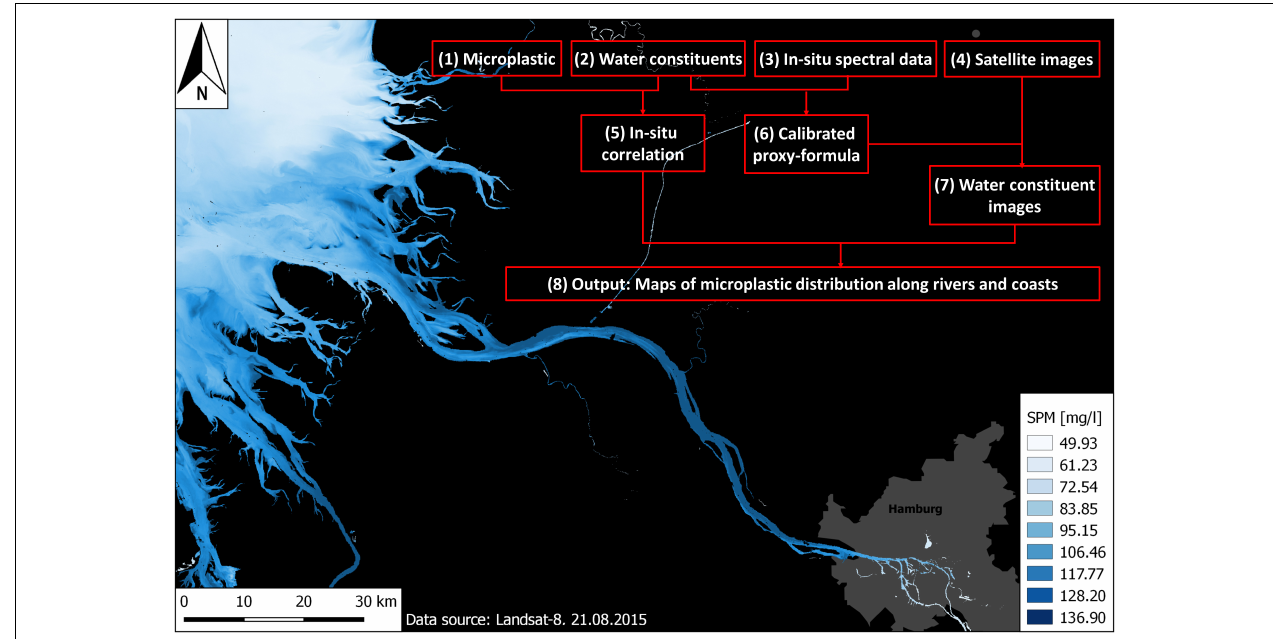
FIGURE 4 | Satellite image of suspended particulate matter (SPM) at the Elbe esturay. The diagram illustrates the proposed framework to track microplastic distribution via proxy water constituent maps (software: QGIS 2.14.8).